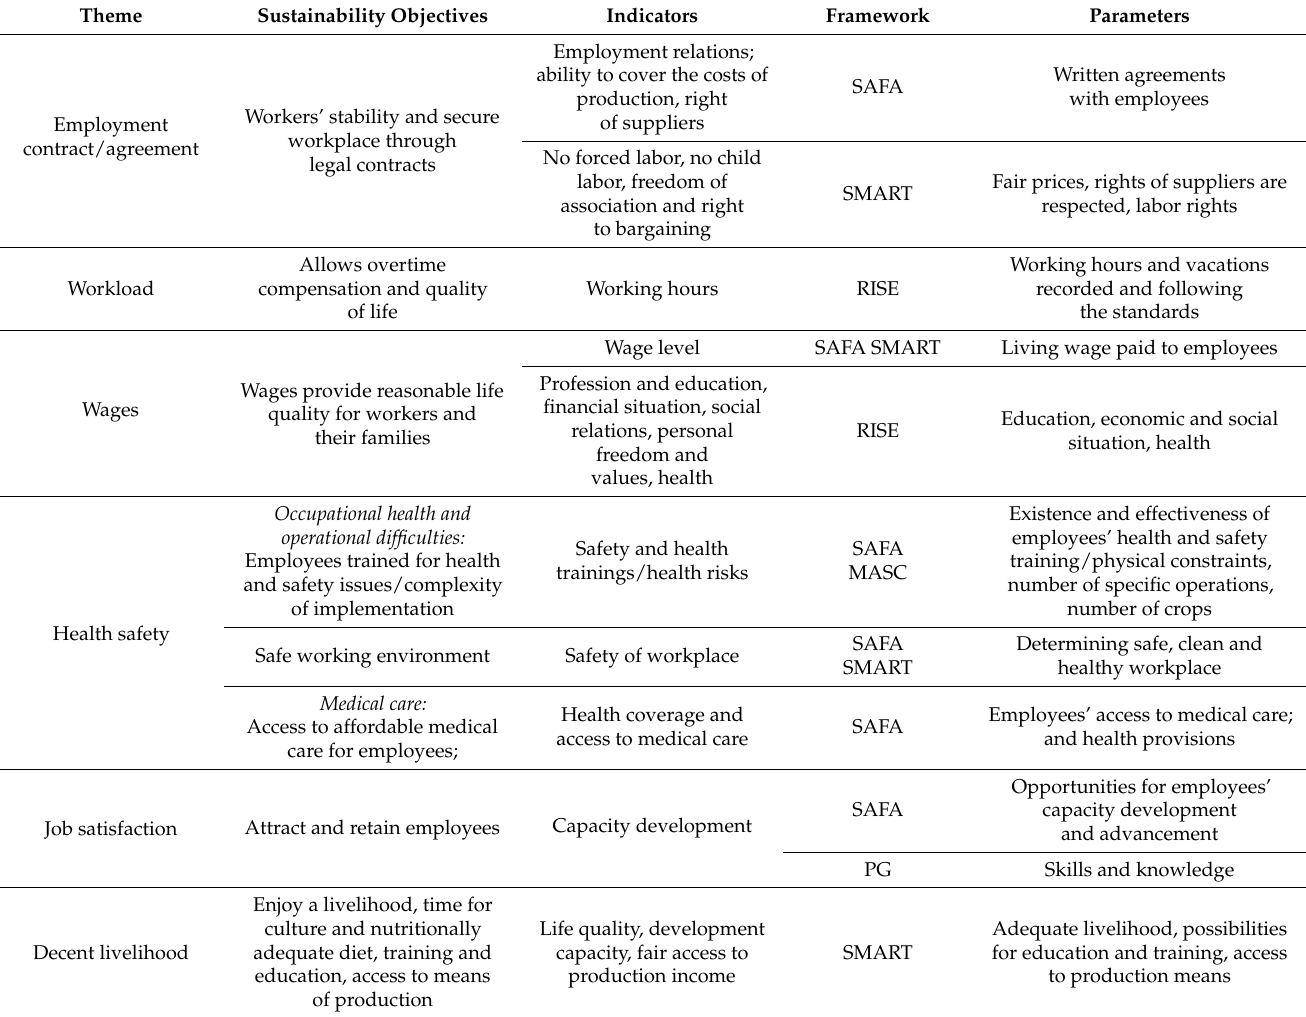
Table 3. Social themes, sustainability objectives, indicators and measured parameters for each framework considered in this